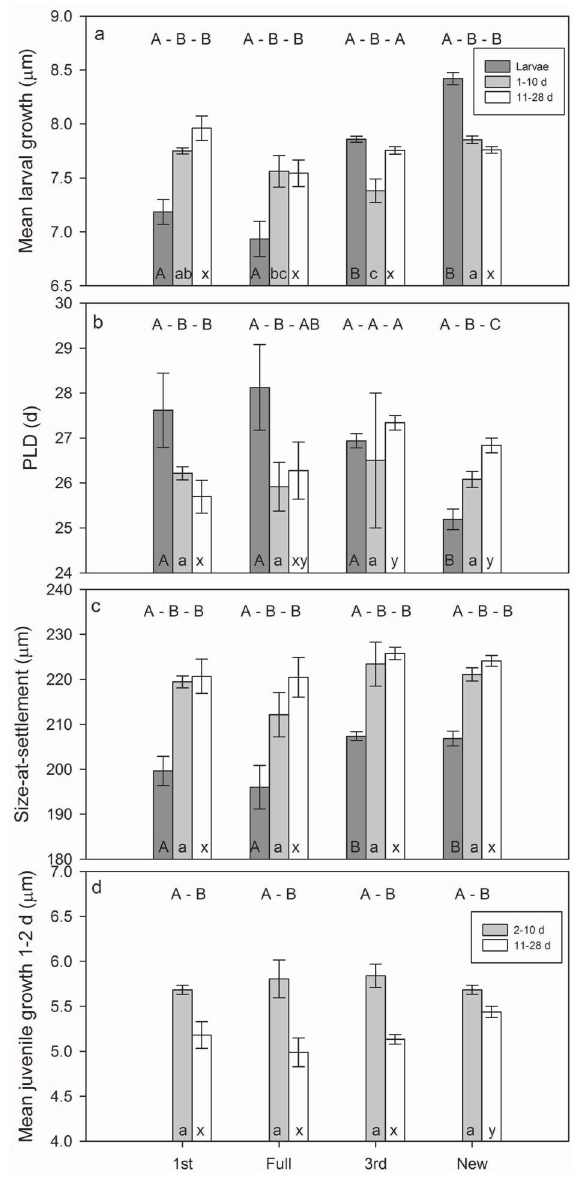
Figure 2. Mean otolith-derived (a) larval growth, (b) pelagic larval duration (PLD), (c) size-at-settlement, and (d) early (2 d) juvenile growth of Stegastespartitus settlement-stage larvae, recruits (1–10 d post settlement), and juveniles (11–28 d) by lunar phase of settlement. Effect of temperature was minimized by including only 25 monthly cohorts collected from May 2003 to August 2008 with mean water temperatures of . 28 u C. Error bars represent SE. Different letters above the bars indicate significant relationships among age groups, within lunar phases. Different letters within the bars indicate significant relationships among lunar phases, within age groups (capital A, B denote differences within larvae, lowercase a, b denote differences within 1–10 d old recruits, lowercase x, y denote differences within 11–28 d old juveniles). Settlement-stage larvae are not included in the last panel because they had not yet settled so did not exhibit juvenile growth.